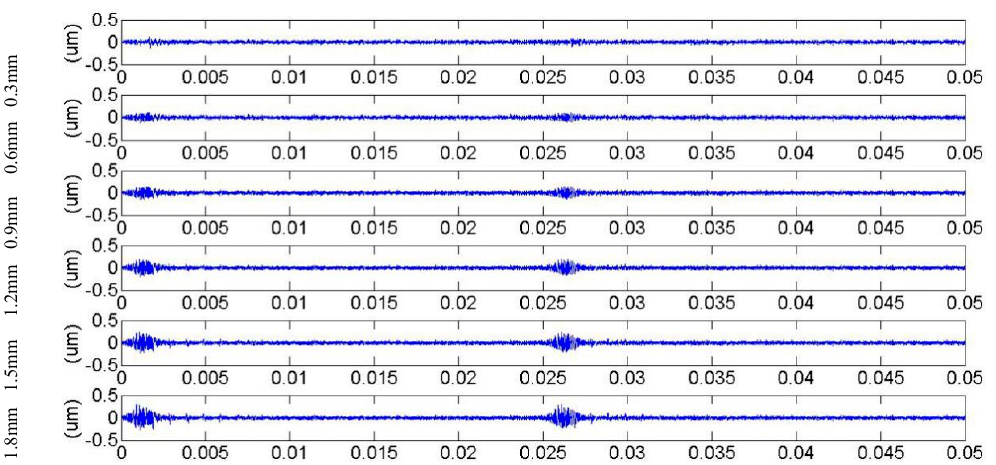
Figure 11. Vibration response for the cracked gear under the 20° pressure angle.